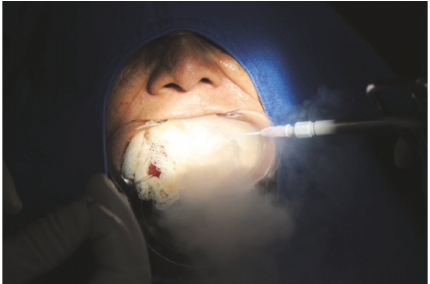
Figure 5: Application of liquid nitrogen on the